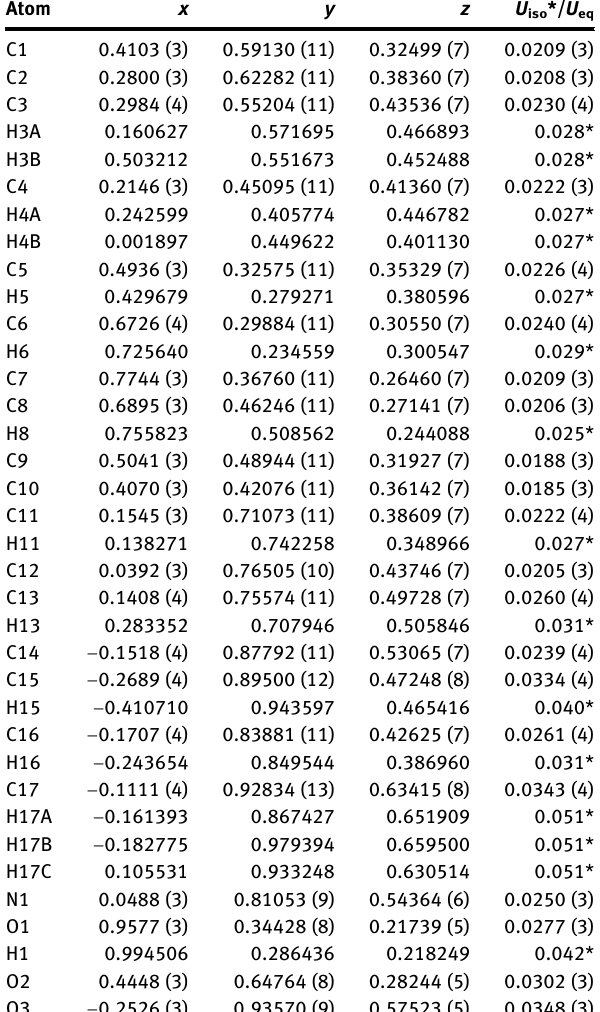
Table  : Fractional atomic coordinates and isotropic or equivalent isotropic displacement parameters (Å 